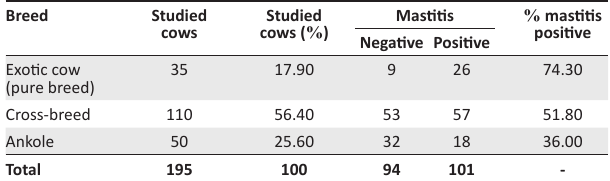
TABLE 6: Mastitis prevalence in different breeds.